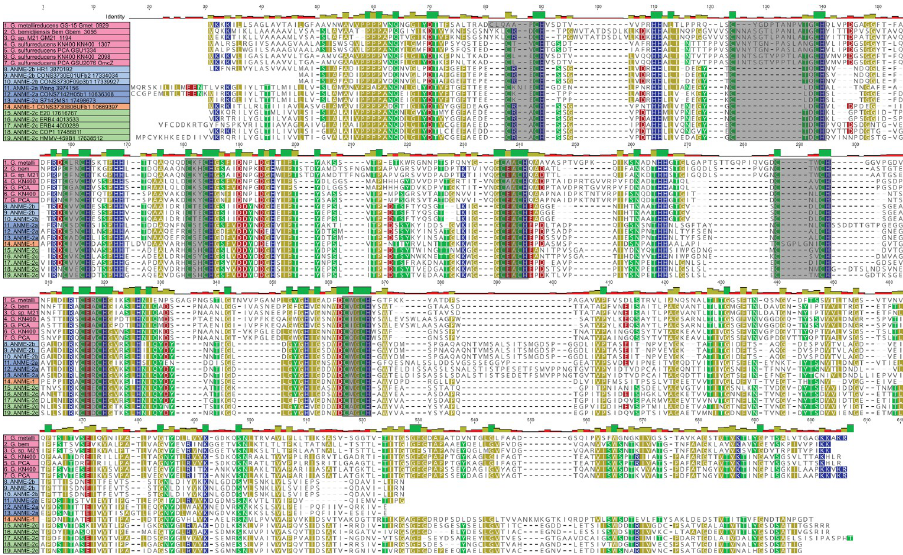
Fig 10. OmcZ homologs in ANME archaea. Protein sequence alignment of OmcZ homologs from various Geobacter species and ANME genomes reported here using muscle 3.8.31 with default settings. The 8 CxxCH-binding motifs are highlighted in gray. Regions of significant sequence identity are present throughout the protein, not just associated with the CxxCH motifs, suggesting conserved function. Alignment file can be found in S1 Data . ANME, anaerobic